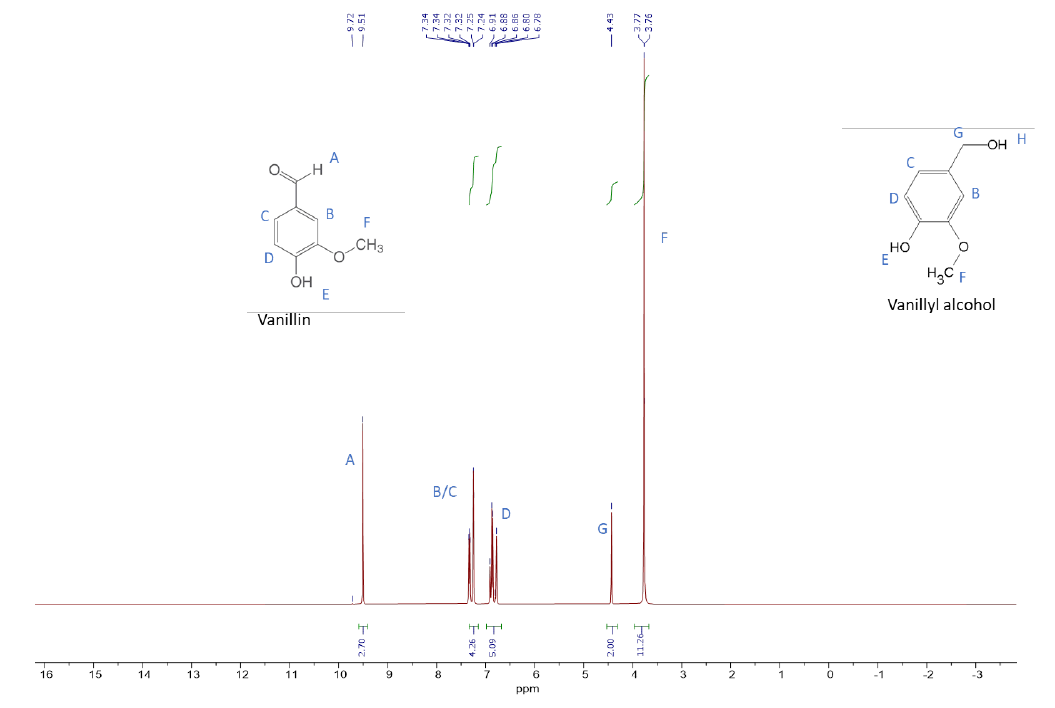
Figure 5. The 1H-NMR spectrum of the first condenser of vacuum distillation Experiment 5. Note: Letters identify the different types of protons present in vanillin and vanillyl alcohol molecules.